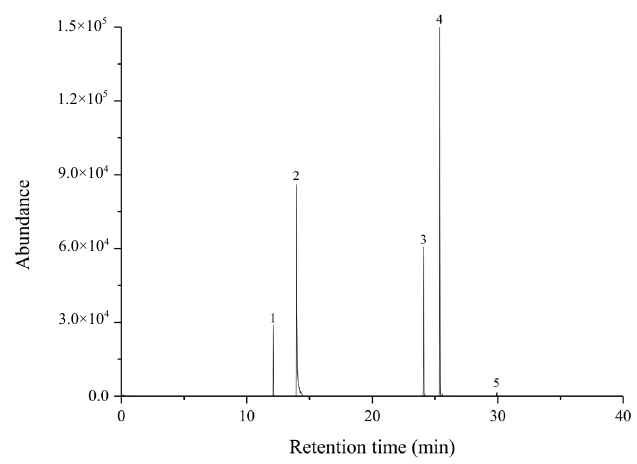
Figure 7. Total ion chromatogram of aging-related body odor using adsorption kit ((1) trans -2-noenal, (2) benzothiazole, (3) hexyl salicylate, (4)a-hexyl cinnamaldehyde, and (5) isopropyl palmitate).